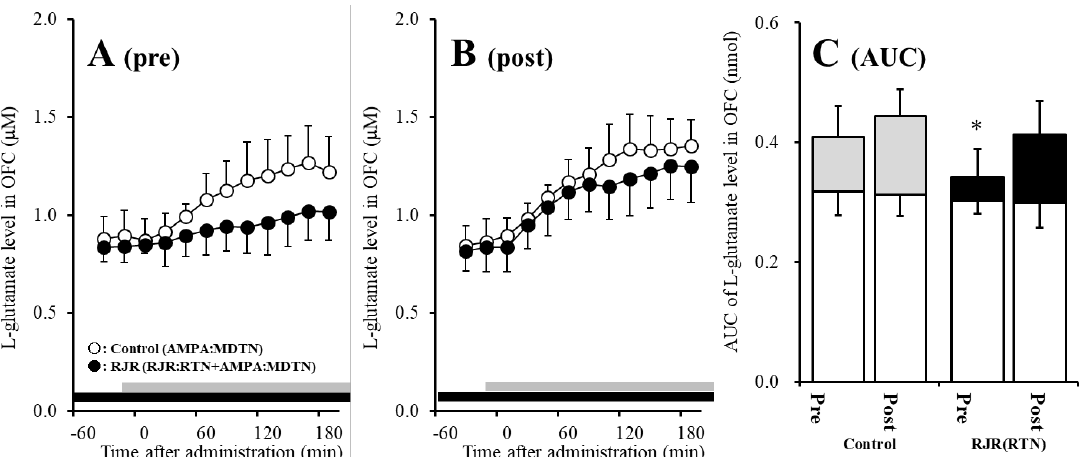
5 of 20 Figure 3. Effects of local administration of 100 μM CBX (red circles) and therapeutic-relevant concentration of CBZ (100 μM: blue circles) and ZNS (500 μM: green circles) into the MDTN on pre- AMPA-evoked (panel A ) and post-AMPA-evoked (panel B ) L -glutamate release (before and after hemichannel activation induced by perfusion with FCHK-MRS into the MDTN for 20 min) in the OFC of S286L-TG. Ordinates indicate mean extracellular L -glutamate level (μM) ( n = 6), and abscissas indicate time after AMPA-evoked stimulations (min). Blue bars indicate the perfusion with CBX, CBZ, or ZNS into the MDTN. Gray bars indicate the perfusion with 100 μM AMPA into the MDTN. Panel C indicates AUC value of extracellular L -glutamate level (nmol) before (basal extracellular L - glutamate level) and after AMPA-evoked stimulation (from 20 to 180 min) of panels A and B. Opened columns indicate the AUC values of basal extracellular levels of L -glutamate in panel A and B. * p < 0.05; relative to control by MANOVA with Tukey’s post hoc test. 2.3. Effects of Local Administrations of (E)-N-Methyl-4-(3-pyridinyl)-3-buten-1-amine oxalate (RJR2403) into the RTN on AMPA-Evoked L -Glutamate Release in the OFC (Study 2) The detailed experimental design of Study_2 was described in following section 4.3.2. Before